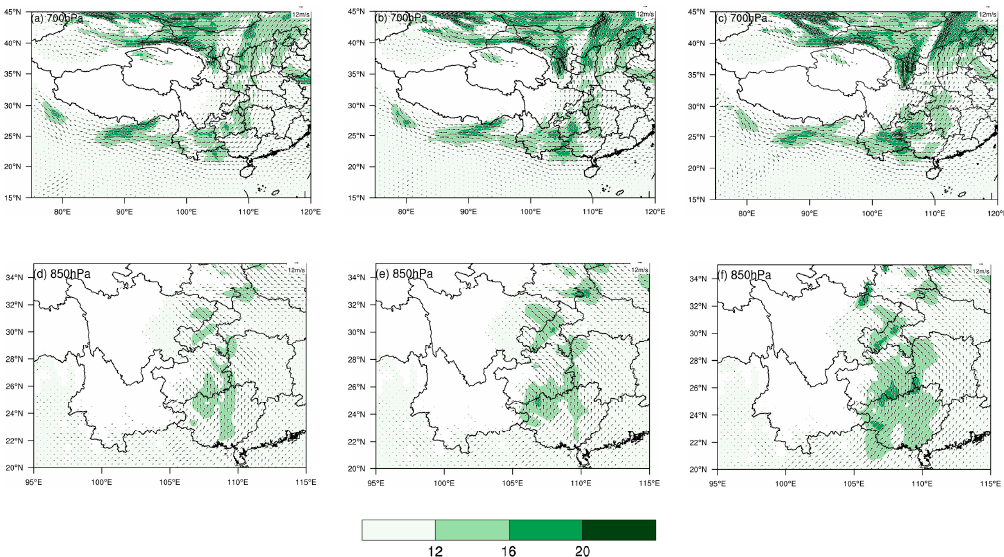
Figure 4. Distributions of wind fields at 700 hPa (vectors, m · s − 1 ), LLJ (shading indicates wind speed over 12 m · s − 1 ); and distributions of wind fields at 850 hPa (vectors, m · s − 1 ), LLJ (shading indicates wind speed over 12 m · s − 1 ) at 0900 UTC 2 May ( a , d ), 1200 UTC 2 May ( b , e ), and 1600 UTC 2 May ( c , f ).